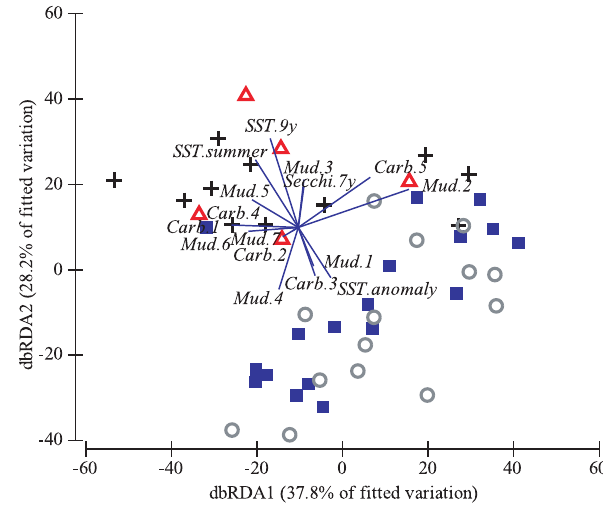
Figure 3. Distance based redundancy ordination (dbRDA) for the fitted model of Symbiodinium communities associated with the hard coral Acroporamillepora and environmental parame- ters for four regions of the Great Barrier Reef. Symbols: n Far Northern, + Northern, & Whitsundays, # Southern GBR. doi:10.1371/journal.pone.0025536.g003 PLoS ONE |